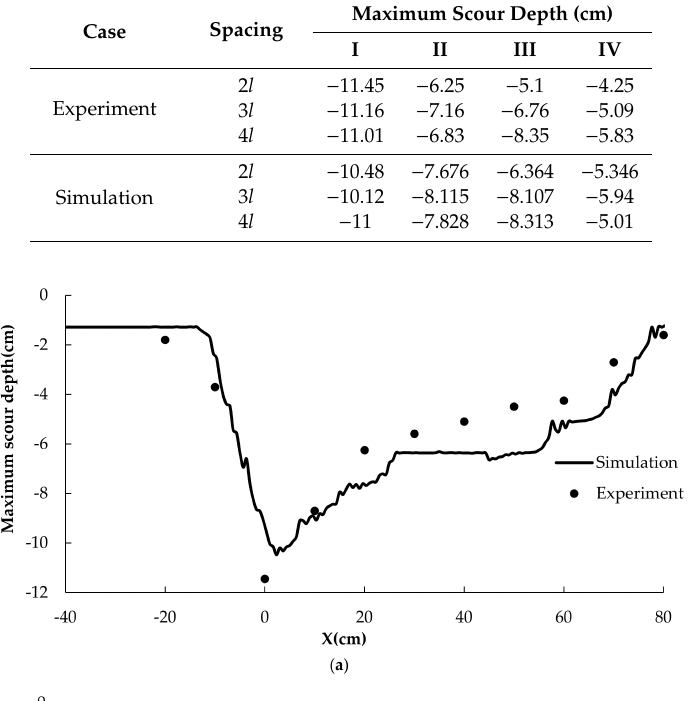
Table 3. The maximum scour depth of the spur dike heads.